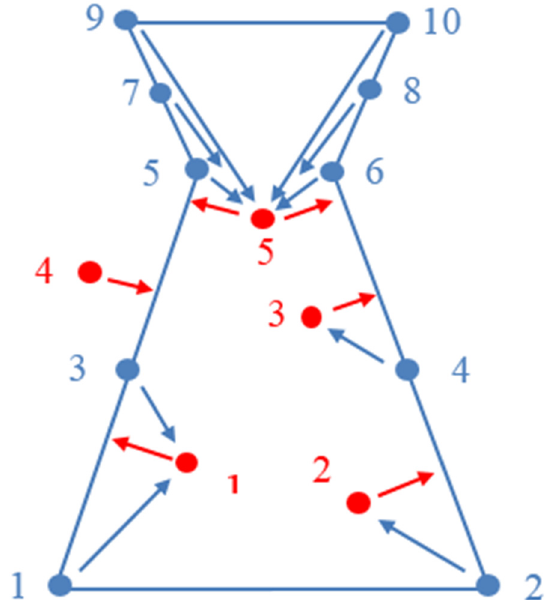
Figure 3. Sketch map of the data term calculation. The red points represent laser points of a pylon. The blue polygon represents the main profile of the pylon model (object), while the blue points represent the key points of the model. The red arrows represent the closest distance from a laser point to object. The blue arrows represent the distance from a key point of object to its nearest laser point.